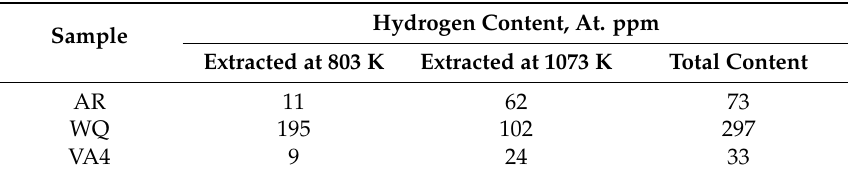
Table 1. Hydrogen content extracted from differently treated